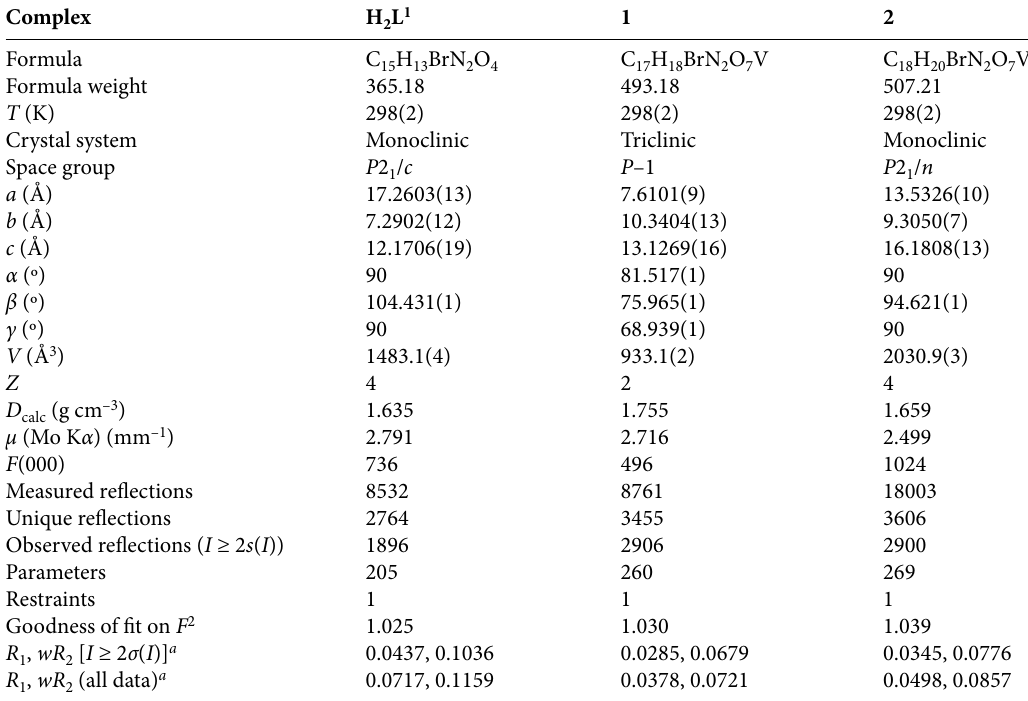
Table 1. Crystallographic and refinement data for complexes 1 and 2